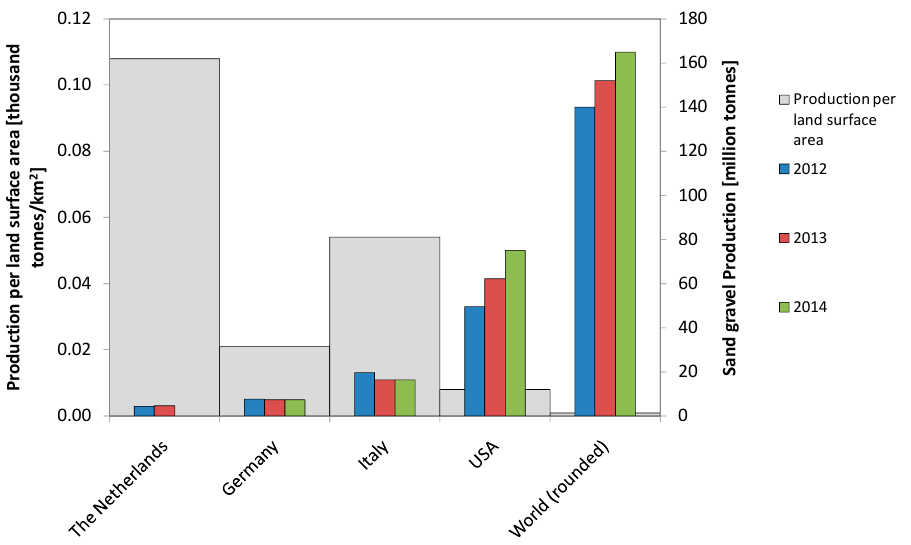
Figure 1. Gravel production of selected countries around the world. Although production in absolute values is not high in The Netherlands (color histogram bars), in relation to its small surface area it is (gray histogram bars). Source [13–15].